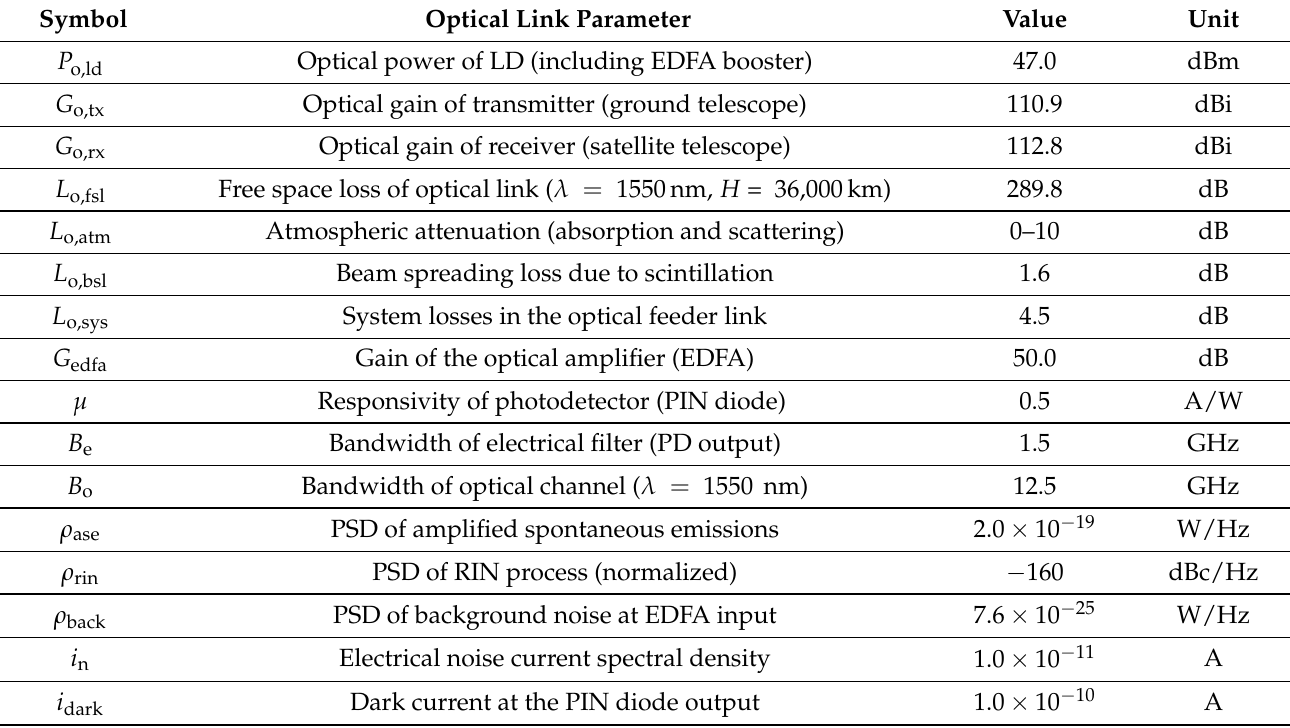
Table 2. Parameters of the optical feeder link used in the NB-IoT satellite system and associated power budget. Symbol Optical Link Parameter